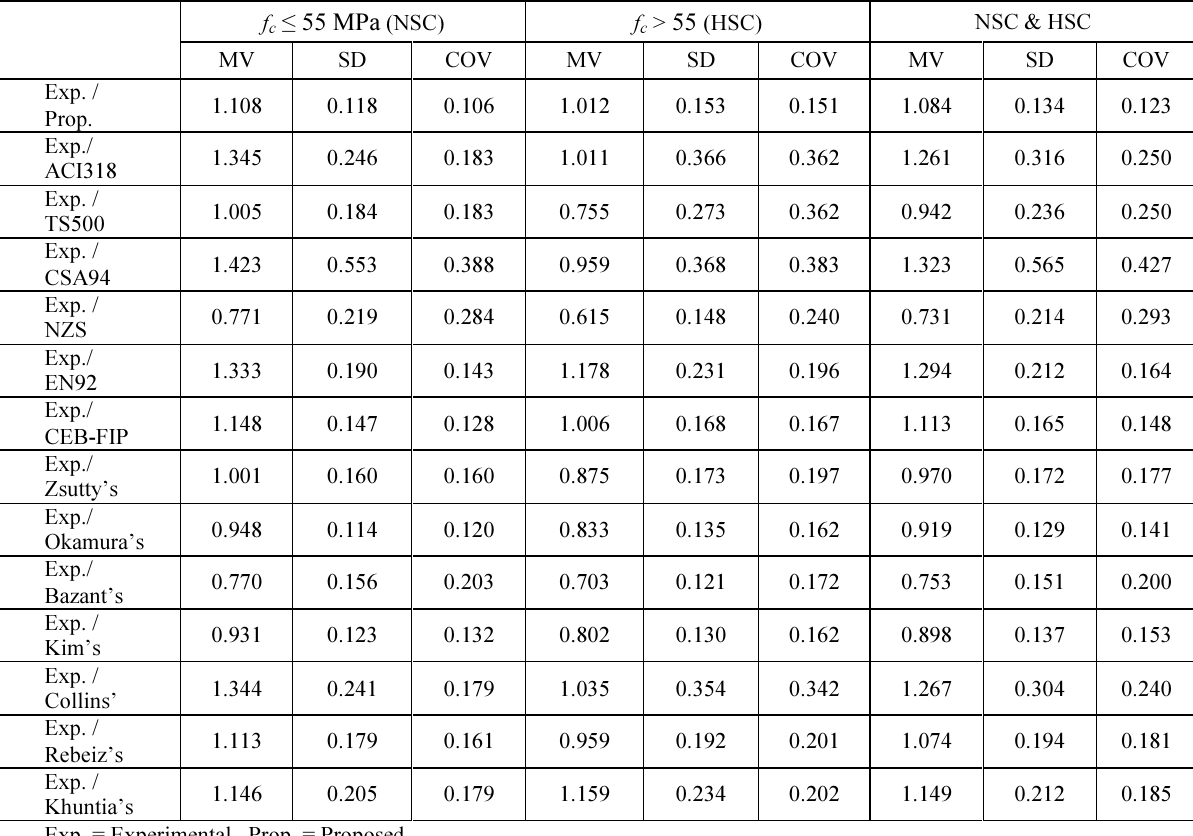
Table 2. Verification of proposed Eq. (12) using entire